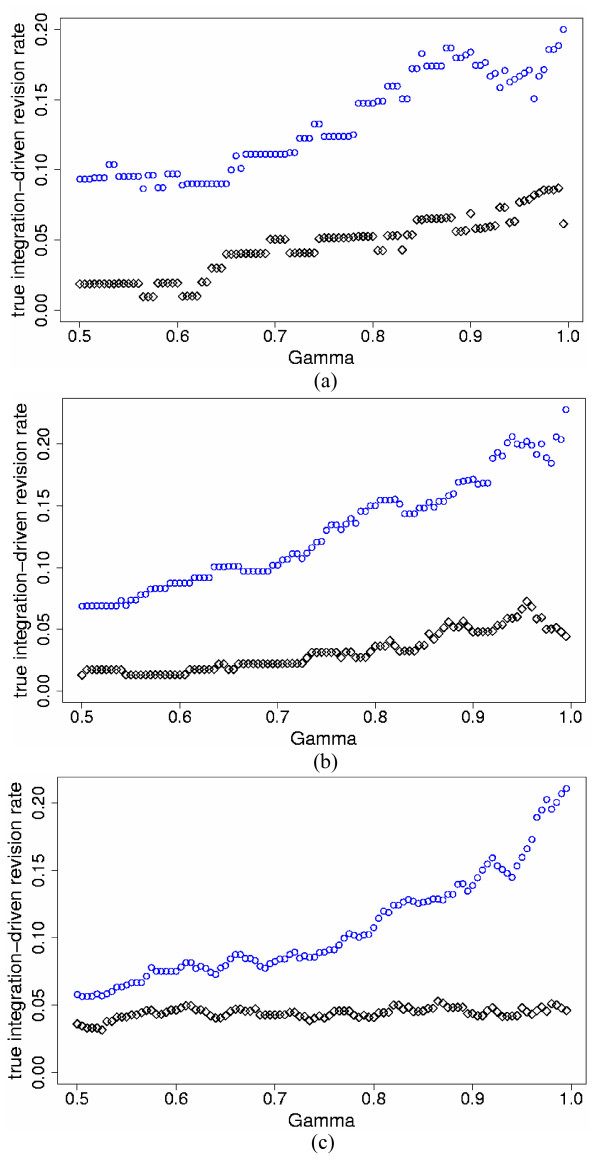
tIRR versus posterior probability of differential expression for the two-study simulation data. True integration-driven revision rate (tIRR) versus threshold values of posterior probability of differential expression γ ≥ 0.50, for the standardized expression integration model (blue circles) and probability integration model (black diamonds) for the two-study simulation data with high mean τg2
 MathType@MTEF@5@5@+=feaafiart1ev1aaatCvAUfKttLearuWrP9MDH5MBPbIqV92AaeXatLxBI9gBaebbnrfifHhDYfgasaacH8akY=wiFfYdH8Gipec8Eeeu0xXdbba9frFj0=OqFfea0dXdd9vqai=hGuQ8kuc9pgc9s8qqaq=dirpe0xb9q8qiLsFr0=vr0=vr0dc8meaabaqaciaacaGaaeqabaqabeGadaaakeaaiiGacqWFepaDdaqhaaWcbaGaem4zaCgabaGaeGOmaidaaaaa@30EE@ = 0.7 (differentially expressed); 0.07 (non-differentially expressed) and the following simulated percent differentially expressed genes ps: a) 5%; b) 10%; c) 25%.